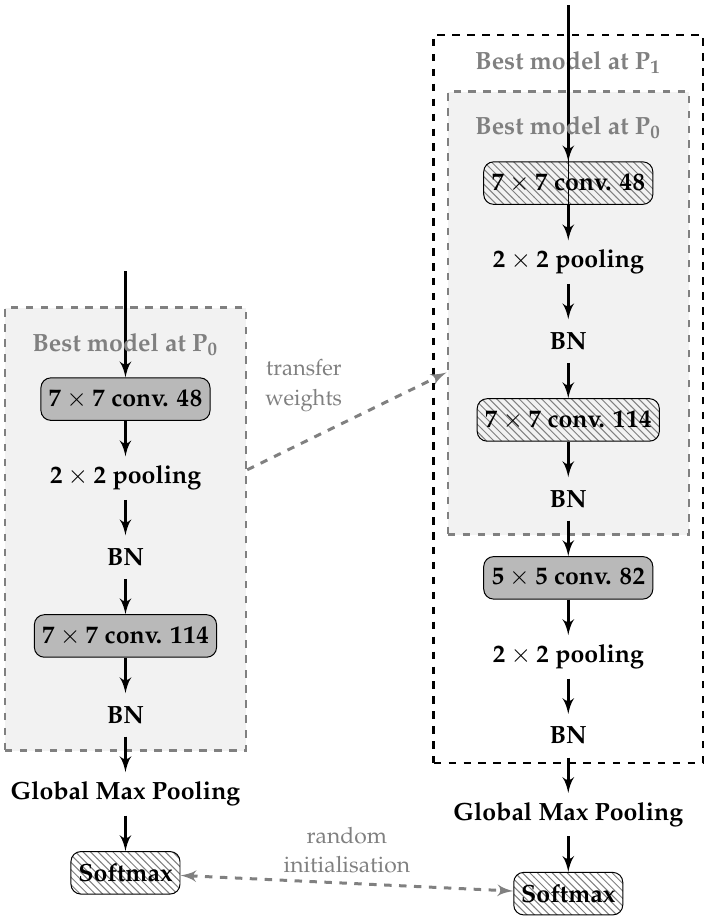
Figure 5. CNN grows deeper when a new phase begins (Left: Phase 0, right: Phase 1). In this graphical representation, the best model obtained in Phase 0 is reported on the left-hand side. Note that the section inside the dashed box indicates the optimised part, while the last two blocks are added after the optimisation process to complete the CNN with the output node. To enter Phase 1, or any subsequent n th phase, the model obtained in the previous phase gets copied and the new additional layers added as previously explained to form the structure on the right-hand. The newly and deeper CNN models